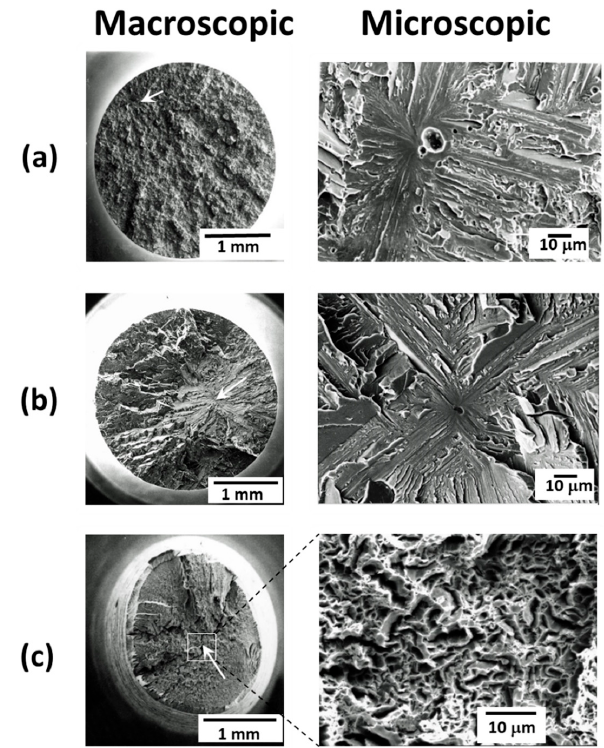
Figure 5. Macroscopic (left) and microscopic (right) SEM images of the fracture surface of tensile specimens tested at − 196 °C of: ( a ) Random, ( b ) <100> and ( c ) <110> processing conditions. White arrows indicate the fracture initiation zone.